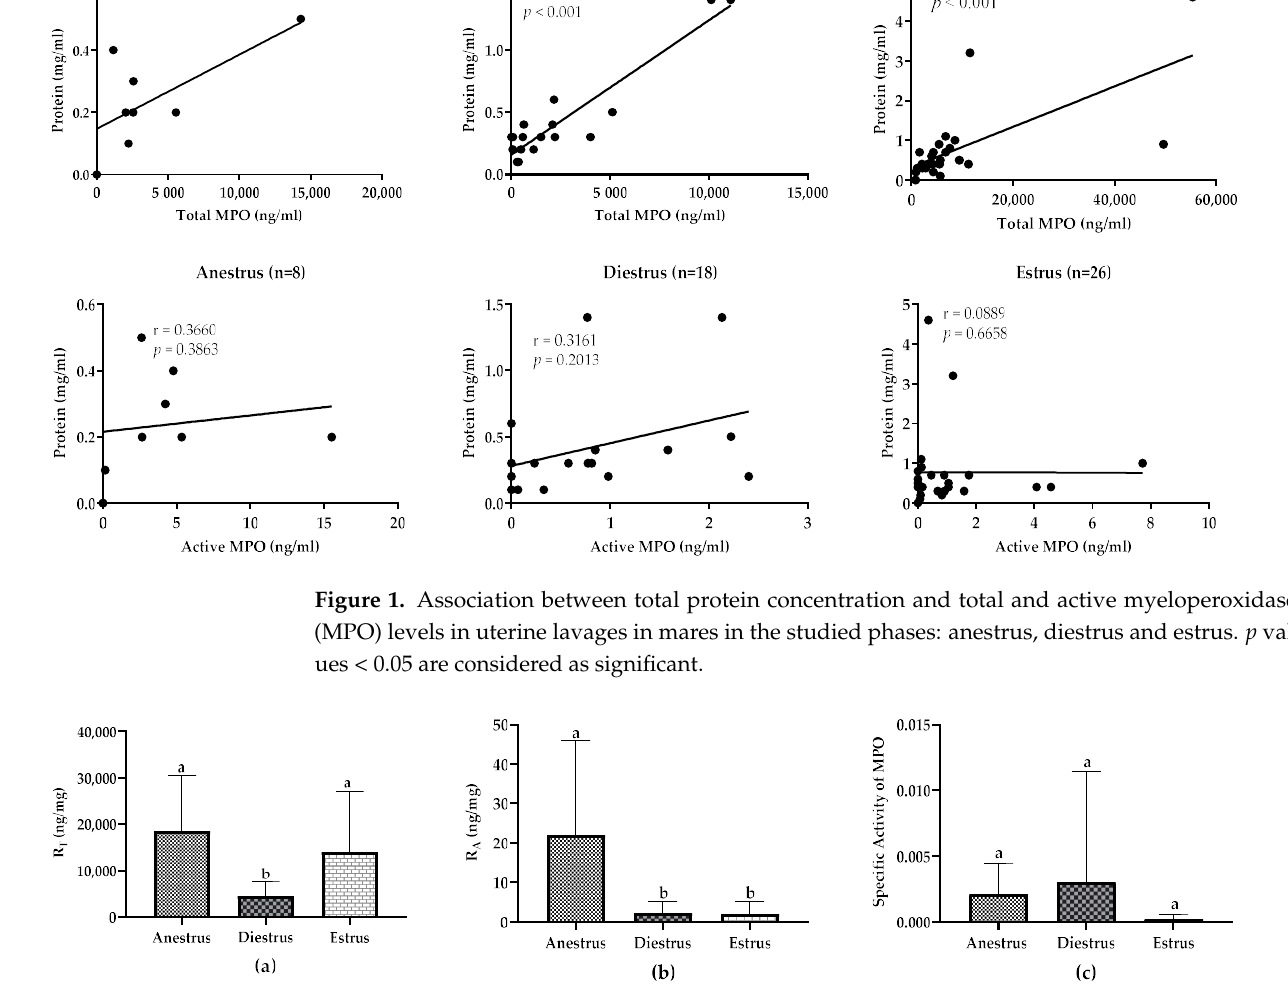
Figure 2. Myeloperoxidase (MPO) in uterine fluid of mares in anestrus, diestrus and estrus in ab- sence of inflammation: ( a ) Total MPO/total protein ratio (R T ), ( b ) Active MPO/total protein ratio (R A ), ( c ) Specific Activity of MPO (active MPO/total MPO). Data are displayed as raw data (mean with SD). Columns with a different superscript are statistically different ( p < 0.05).